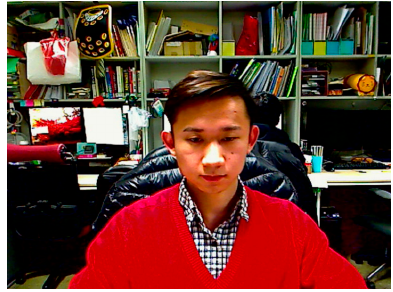
Figure 4. Example of a captured image.